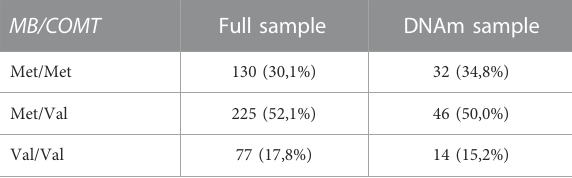
TABLE 2 Differences between the DNAm levels of the fi ve CpG sites using Durbin-Conover